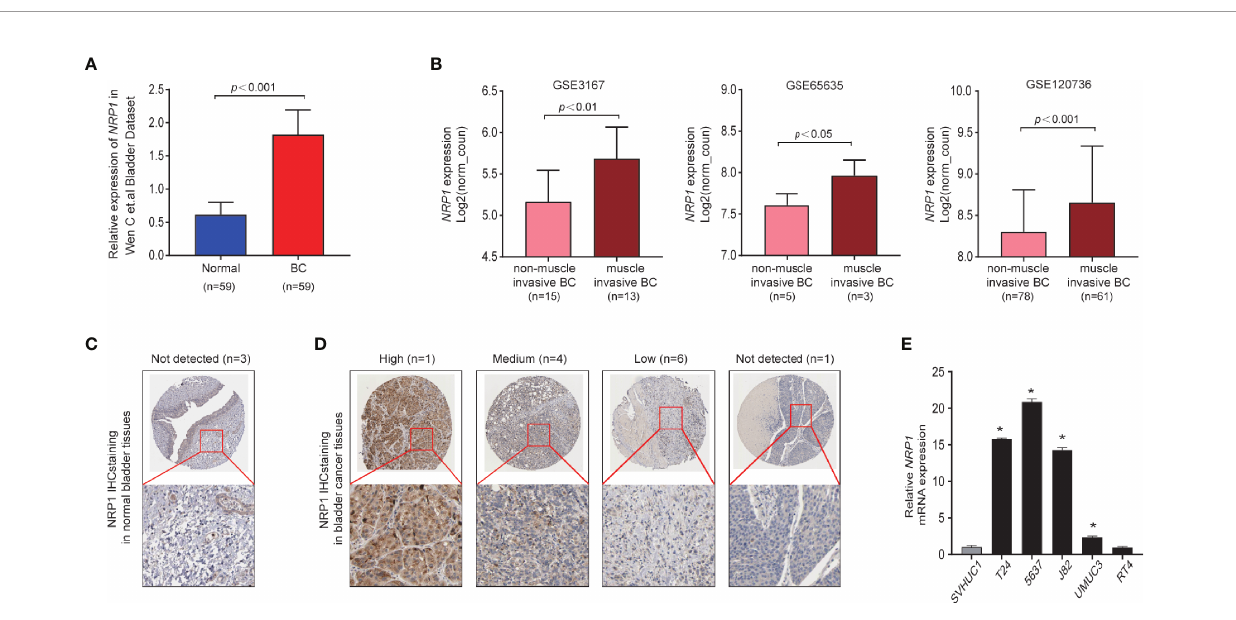
FIGURE 1 | NRP1 is upregulated in BC. (A) NRP1 was overexpressed in BC tissues (n = 59) compared with that in normal bladder tissues (n = 59) in the Wen C et al. bladder dataset. (B) Expression of NRP1 was upregulated in muscle invasive BC tissues compared with that in non-muscle invasive BC tissue samples in the GSE3167, GSE65635, and GSE120736 datasets, respectively. (C) Representative IHC images of NRP1 in normal bladder tissues and in (D) BC tissues. (E) The levels of the NRP1 mRNA in SVHUC1 cell line and fi ve BC cell lines examined using real-time PCR. The average NRP1 mRNA expression was normalised to the expression of b -actin. Three independent experiments were conducted for each assay and * p < 0.01 vs . the SVHUC1